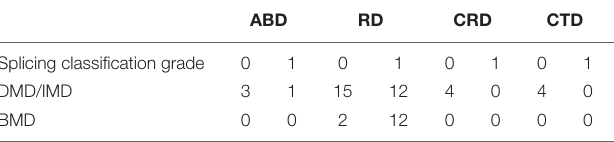
TABLE 4 | Correlation between splicing classification grade and phenotypes in nonsense mutation cases. ABD RD CRD